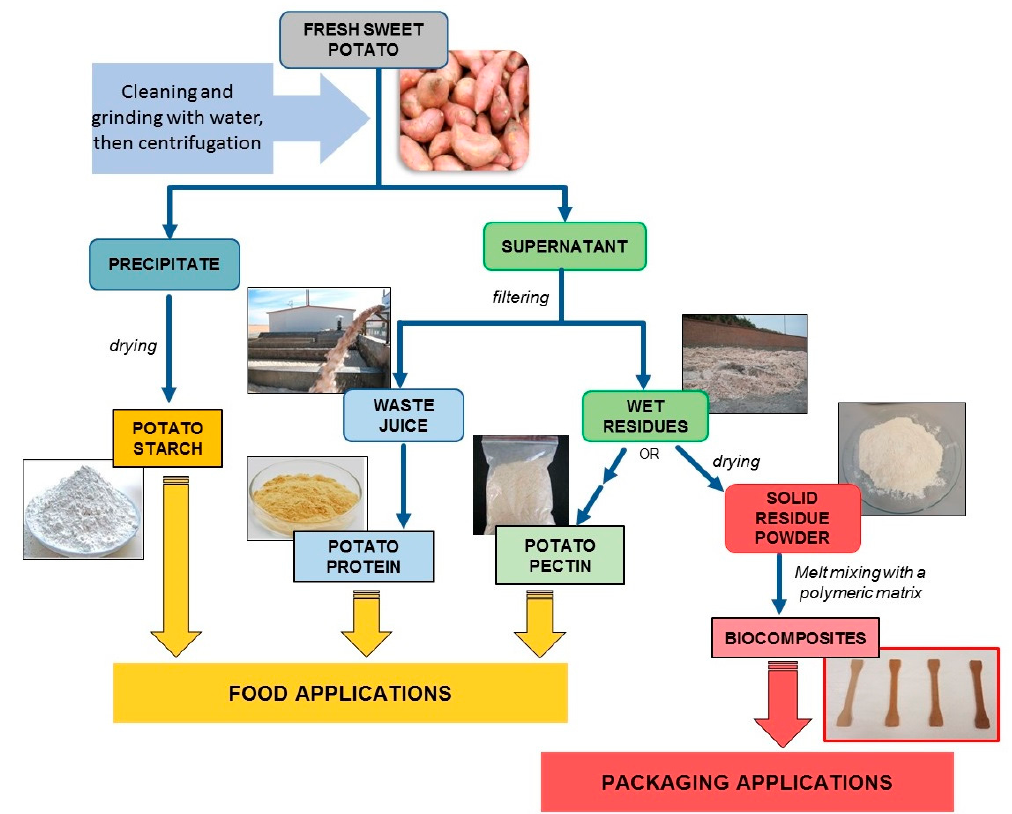
Figure 1. Cascading approach developed in the framework of the NoAW project to valorize the by-products obtained after the extraction of starch from potatoes.